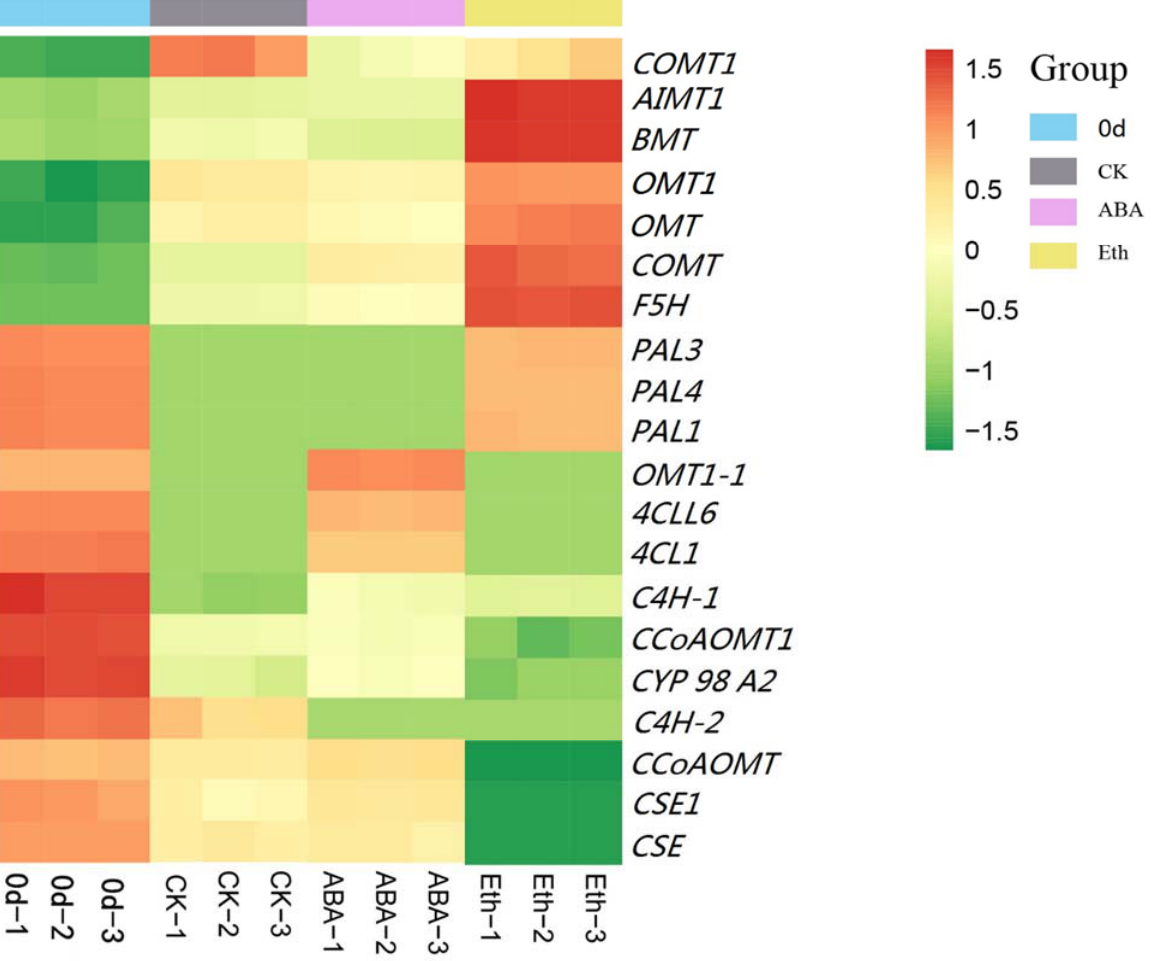
Figure 6. Clustering heat map of differentially expressed genes. COMT: caffeic acid 3 ‐ O ‐ methyl